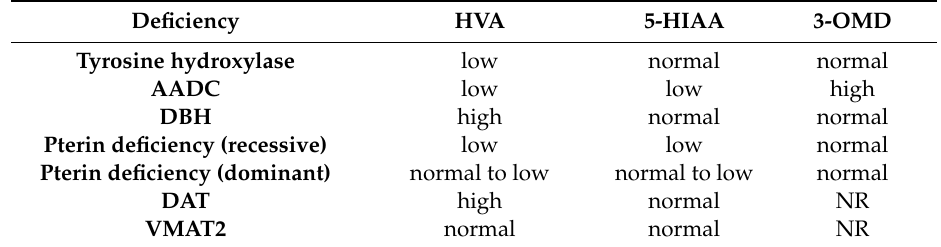
normal normal 3-OMD,3- O -methylDOPA;AADC,aromaticaminoaciddecarboxylase; DAT;dopaminetransporter; DBH,dopamine ß hydroxylase; 5-HIAA, 5 hydroxyindolacetic acid; HVA, homovanillic acid; NR, not reported; VMAT2,